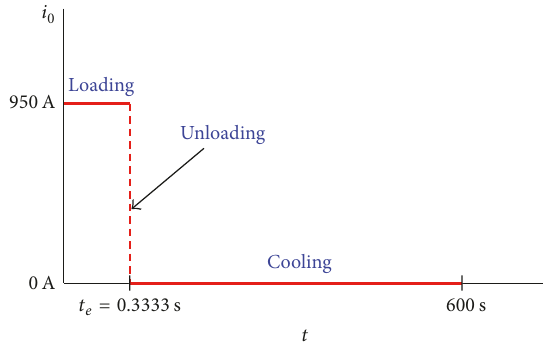
Figure 6: Electric loading, unloading, and cooling